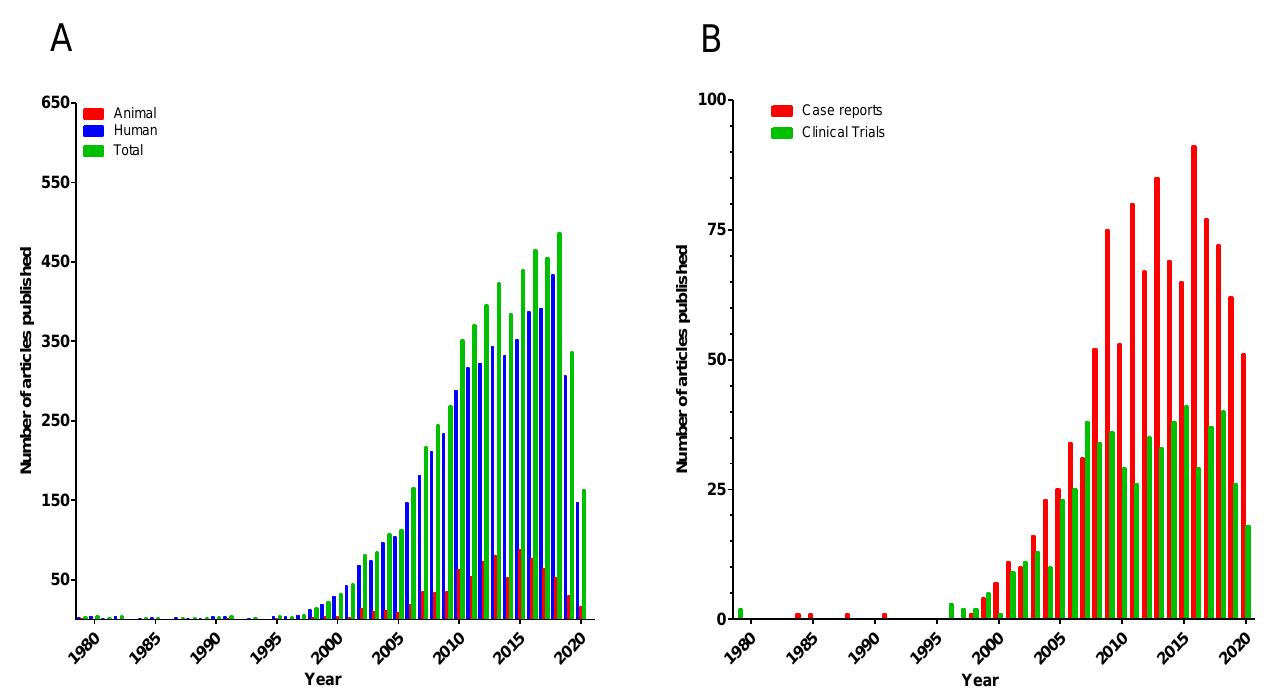
Figure 1. Result of PubMed searches of ( A ) number of articles published related to “deep brain stimulation (DBS)” in animal studies (red), human studies (blue), and both (green) and ( B ) number of case reports on DBS (red) and clinical trials (as defined by the PubMed filters) (green).